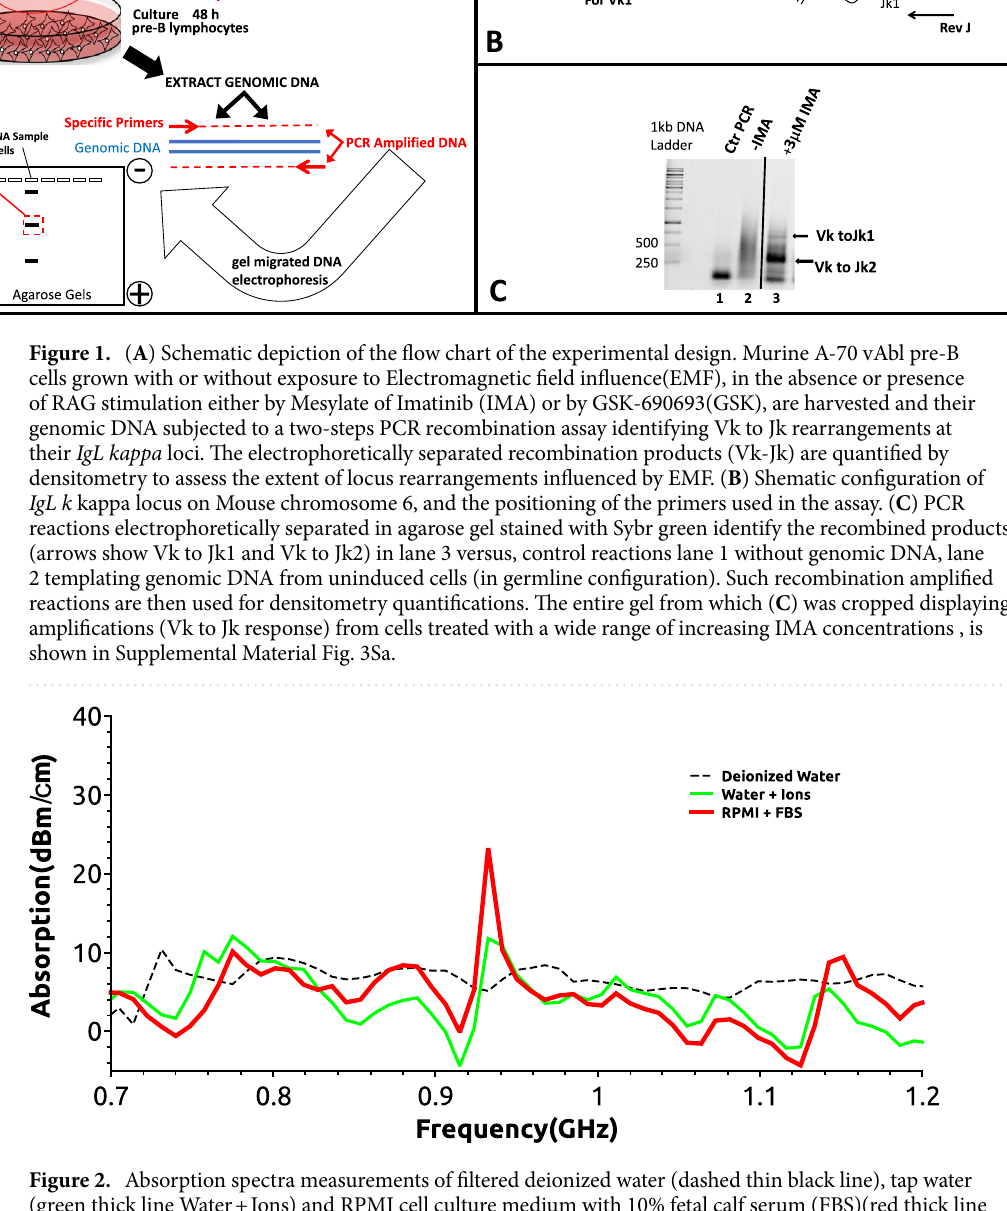
Fig. 3Sa, gel and quantified data from three such experiments shown in Fig. 3Sb histograms. The lowest drug concentration (3 µM for IMA and of 10 µM for GSK,) for which maximal recombination effects are obtained, is used for each drug in our irradiation assays. For linear range quantifications of the image scans each reaction uses genomic DNA template at least at three distinct dilutions from the cellular extraction stock solution and the final result may be reported as an average of the three quantified products values corrected by the histone H1 band intensity of the corresponding sample. In Supplemental material in Fig. 3Sc an 3Sd a set of nested PCR